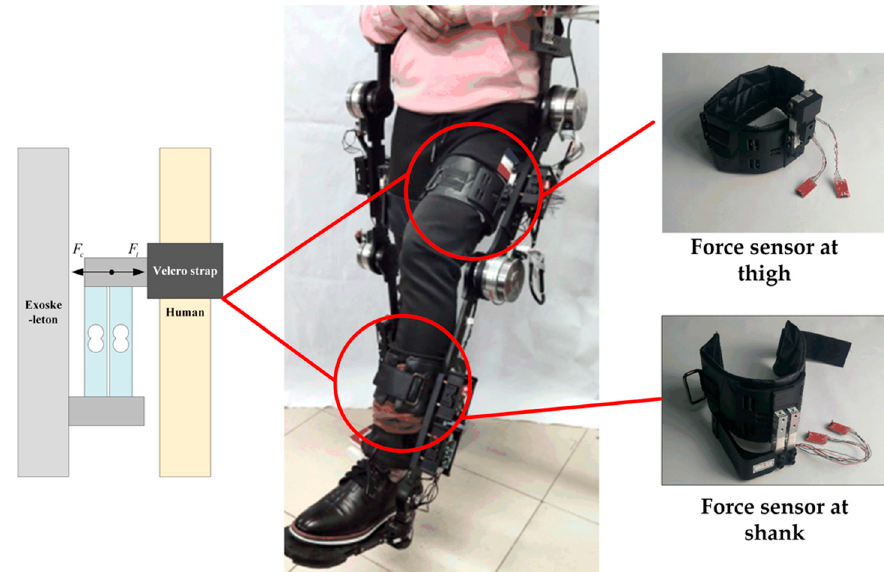
Figure 2. Force sensor installed between the exoskeleton and the human.